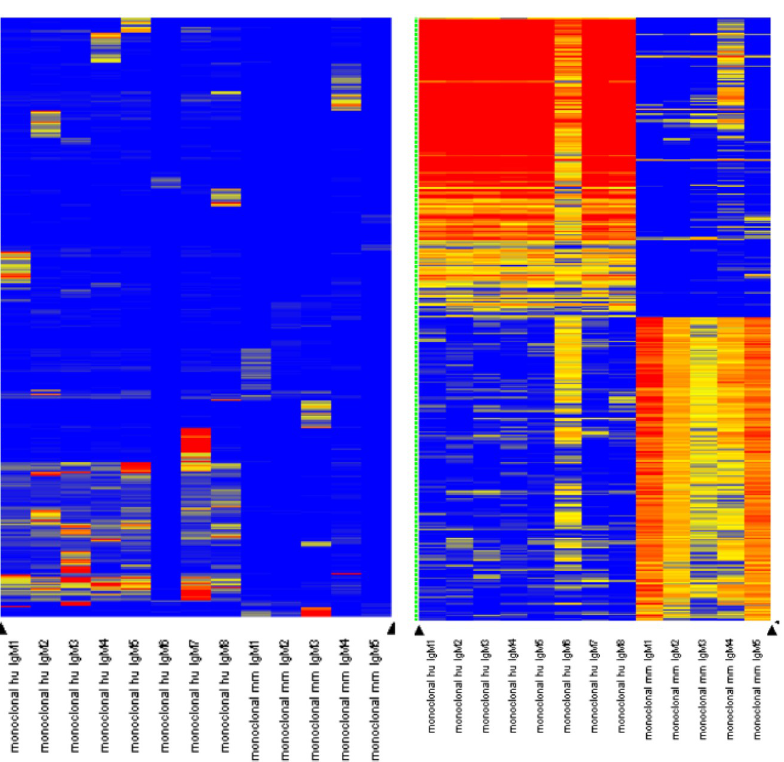
Fig 7. Heatmap for the 13 different clinical monoclonals. Each of the clinical monoclonals was tested exactly like the 24 commercial antibodies, to find 50 peptides that were unique for each antibody (see Fig 4). Left: For each of the antibodies, some unique peptides were identified but for the human antibodies, many peptides overlapped suggesting a common target. The mouse antibodies had less overlap with either the human or other mouse antibodies. Right: We applied a general filter for high binding peptides. Here there are 200 peptides identified for the human antibodies (left) and 200 for the mouse antibodies (right). These high-binding peptides overlap with each other, but not between mouse and human reinforcing the possibility that these two sets of antibodies are against different protein targets. These 200 peptides were used to BLAST all human and all mouse proteins, respectively (see Table 4).